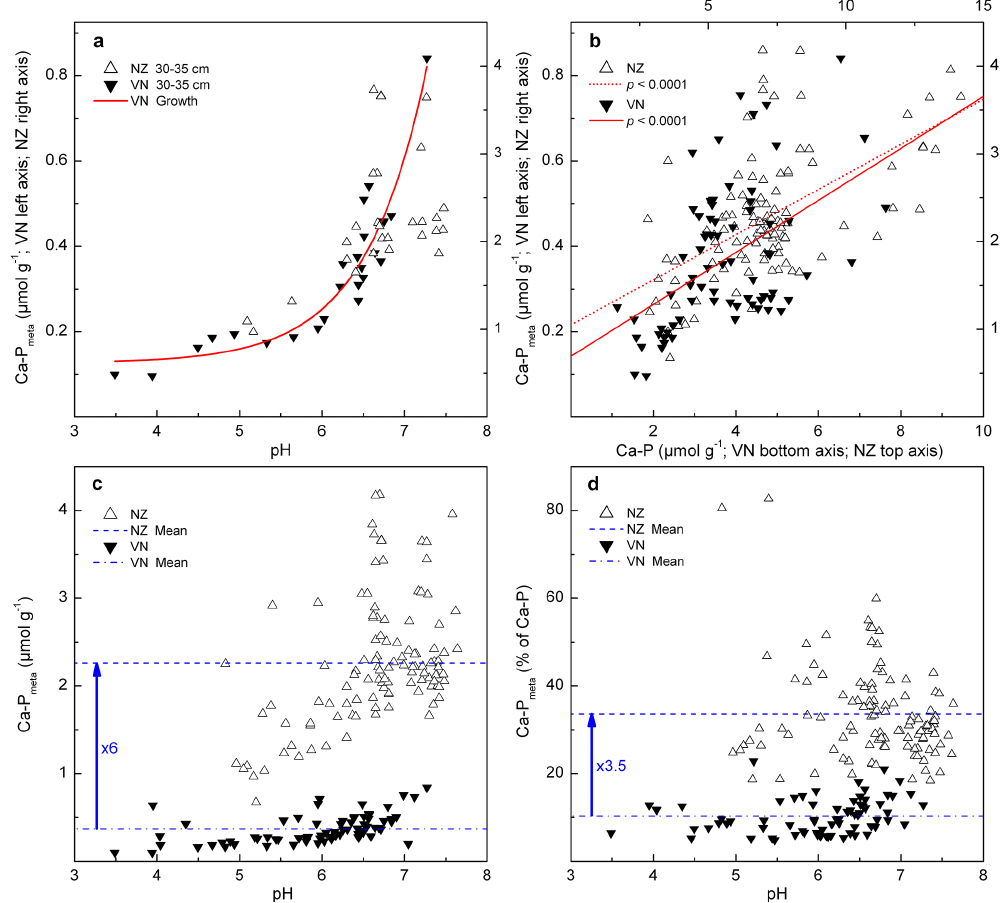
Figure 4. Accumulation and pH dependence of metastable Ca-P (Ca-P meta ) along transects at the Firth of Thames (NZ) site compared to the Saigon River delta (VN) site. (a) Increase of Ca-P meta with pH (exponential; 30–35cm). (b) Linear regressions of Ca-P meta vs. total Ca-P (all plots and depths; NZ: r = 0.57, p < 0.0001; VN: r = 0.50, p < 0.0001). (c) Ca-P meta vs. pH (all plots and depths). Mean Ca-P meta concentration at the Firth of Thames site ca. 6 times that of the Saigon River delta site. (d) Ca-P meta in % of total Ca-P vs. pH (all plots and depths). Mean percentage ca. 3.5 times higher for the Firth of Thames site. Note different axis ranges for the two sites in (a) and (b)